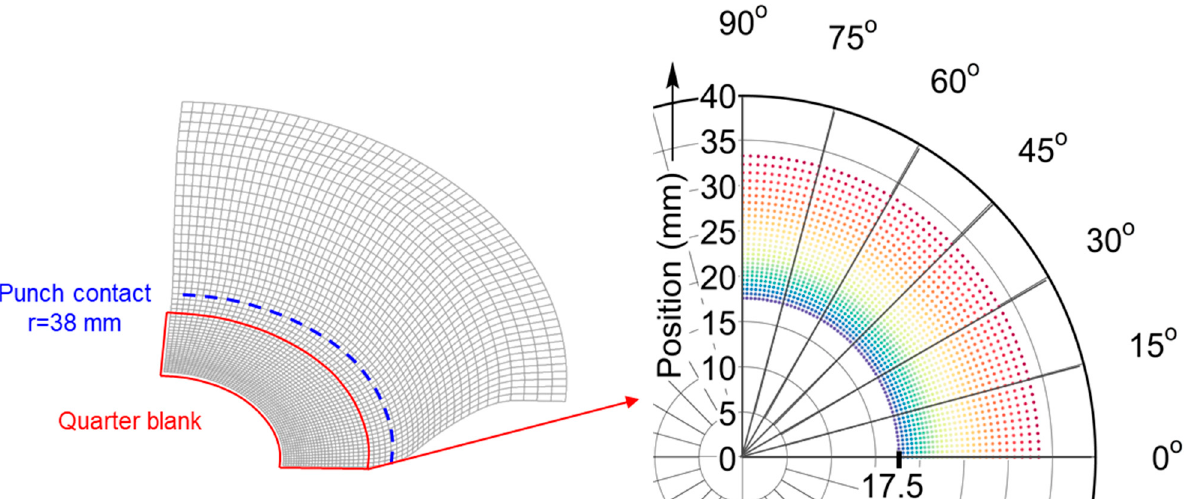
Figure 9. Color-coded identification of the output points of the mesh of the blank for the analysis of stress states in hole-expansion.